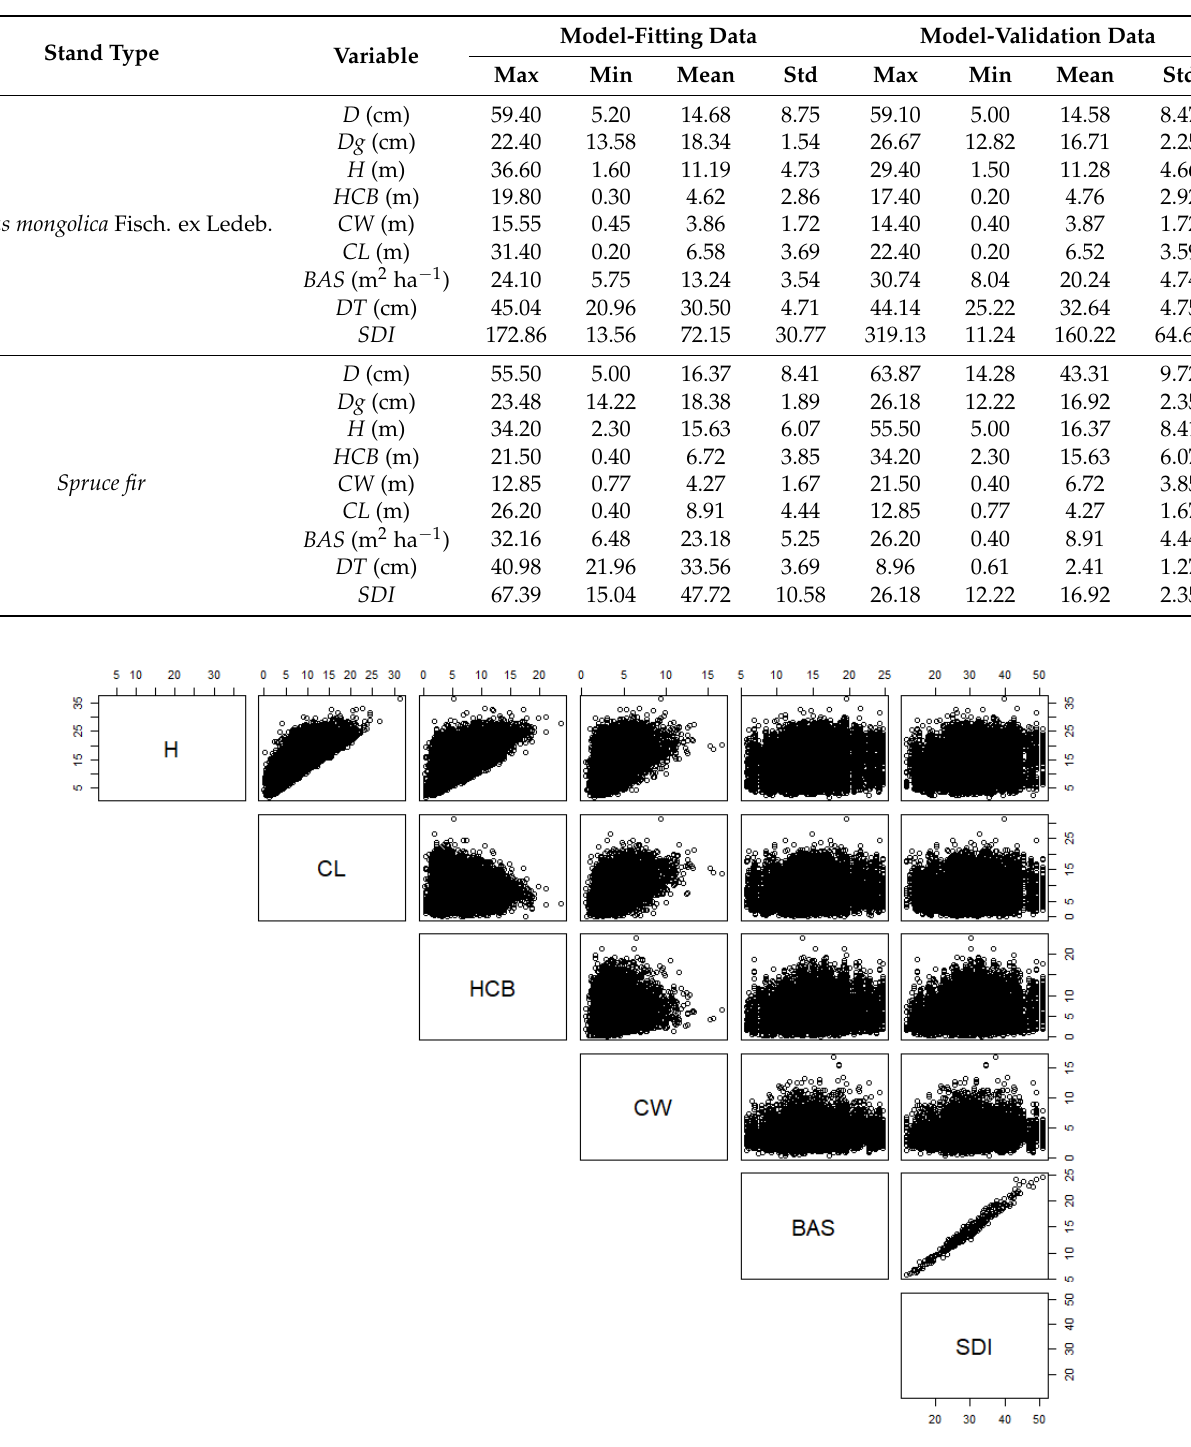
Figure 2. The relationships of individual tree H (total tree height), CL (crown length), HCB (height to live crown base) with stand factors, including Dg , DT , BAS , and SDI ( H : total tree height (m); CL : crown length (m); HCB : height to live crown base (m); CW : crown width (m); BAS : stand basal area (m 2 · ha − 1 ); SDI : stand density